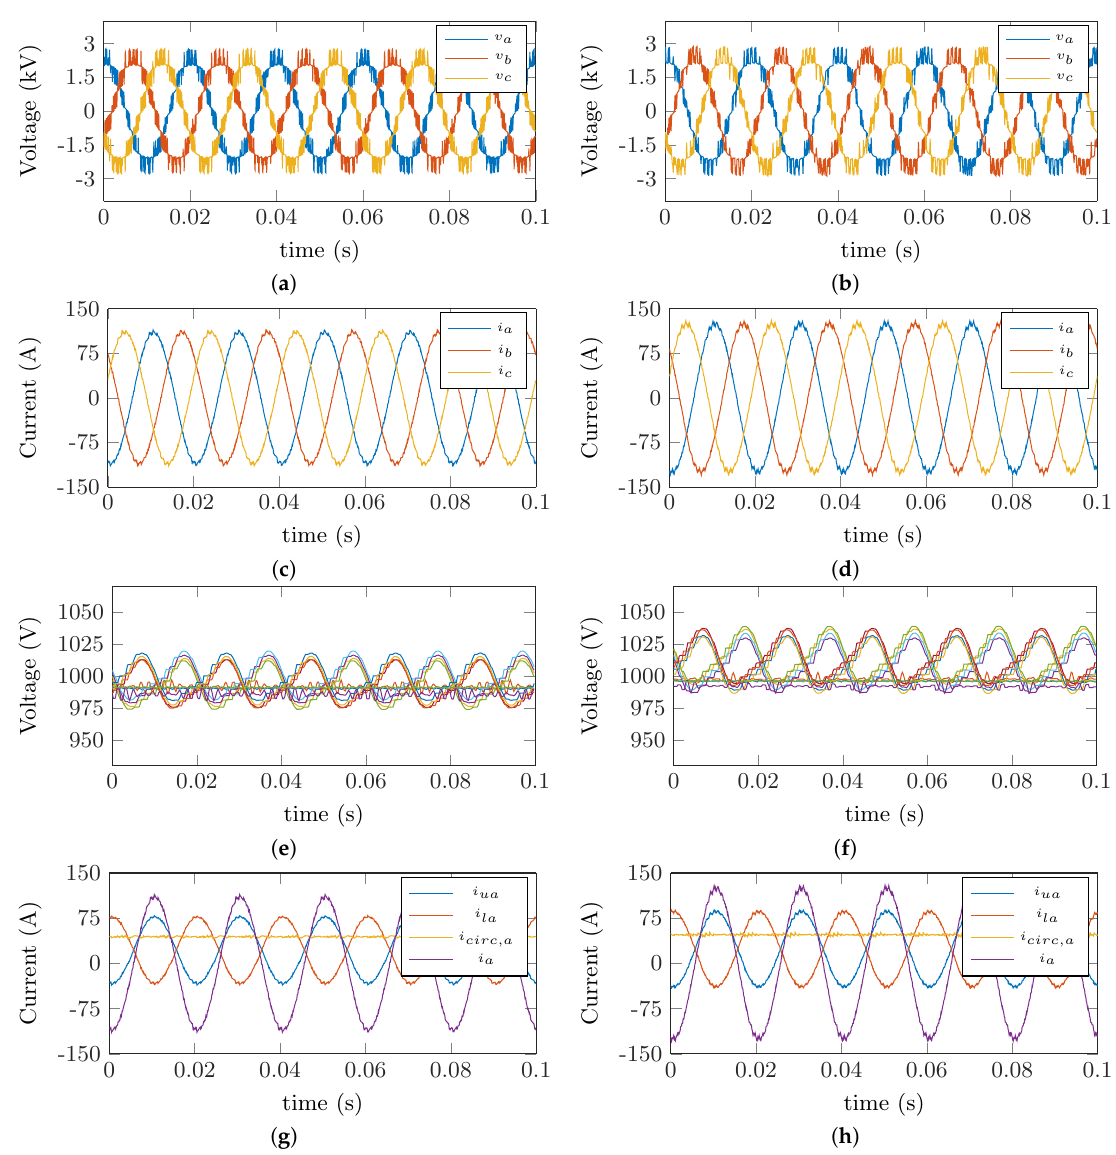
Figure 12. Output waveforms: ( a ) load voltages during ESS charging; ( b ) load voltages during ESS discharging; ( c ) load currents during ESS charging; ( d ) load currents during ESS discharging; ( e ) SM capacitor voltages during ESS charging; ( f ) SM capacitor voltages during ESS discharging; ( g ) load, circulating and arm currents during ESS charging; ( h ) load, circulating and arm currents during ESS